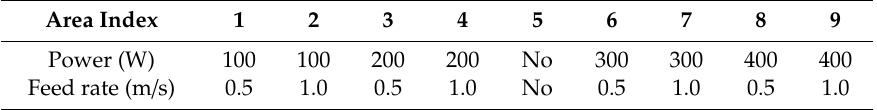
Table 2. Laser-polishing parameters for eight areas.